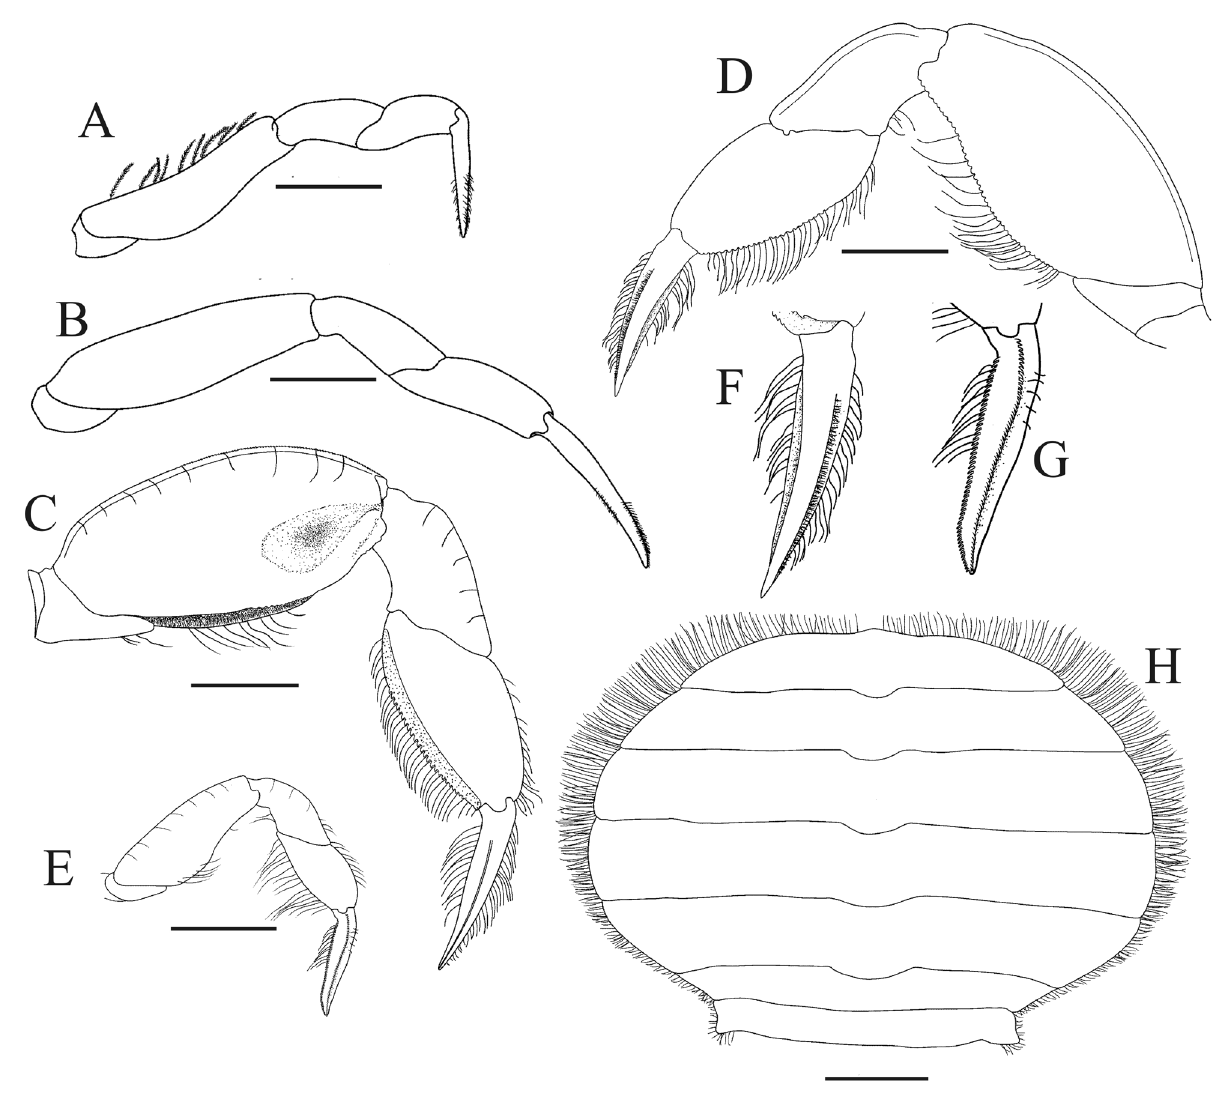
Figure 4. Austinixa marianae n. sp. A–G , male paratype (ICML-EMU 12531); H , female paratype (ICML-EMU 12531). A , Second pereopod, dorsal view; B , third pereopod, dorsal view; C , fourth pereopod, dorsal view; D , fourth pereopod anterior view; E , fifth pereopod, dorsal view; F , dactylus of fourth pereopod, dorsal view; G , dactylus of fifth pereopod, dorsal view; H , ovigerous female pleon. Scale bar = 1